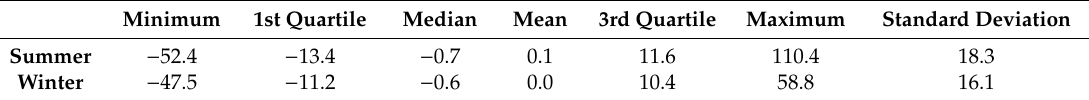
Table 2. Descriptive statistics of the estimated excess mortality (EM) for the period 2000–2015 in Montreal, expressed in percentage (%). Summer spans the months May–September and winter the months